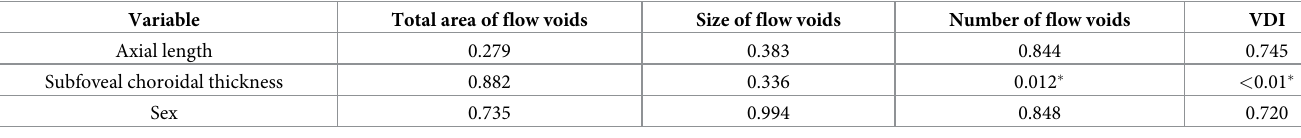
Table 2. Correlations among axial length, subfoveal choroidal thickness, and sex after adjusting for age.